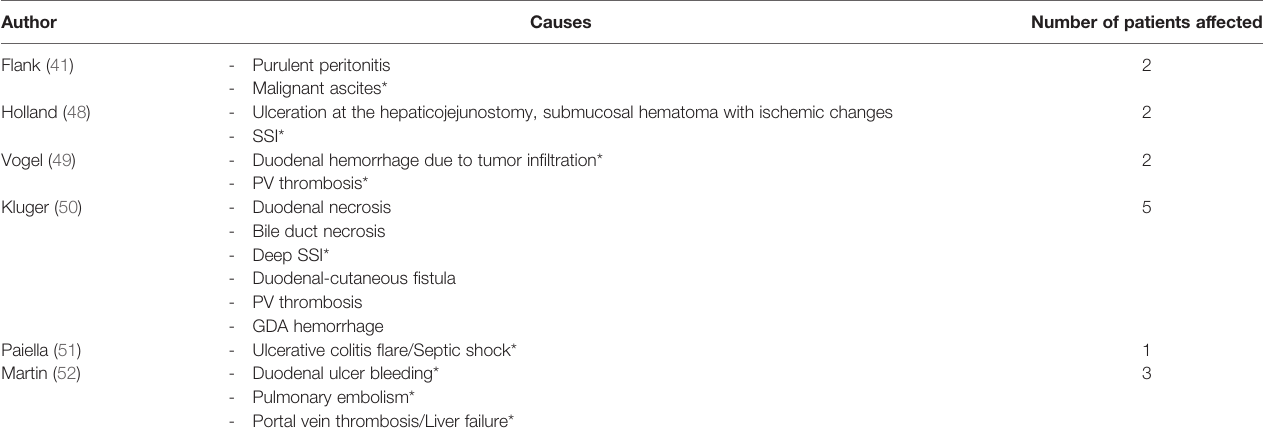
TABLE 2 | Mortality causes (in patients treated with IRE for LAPC)